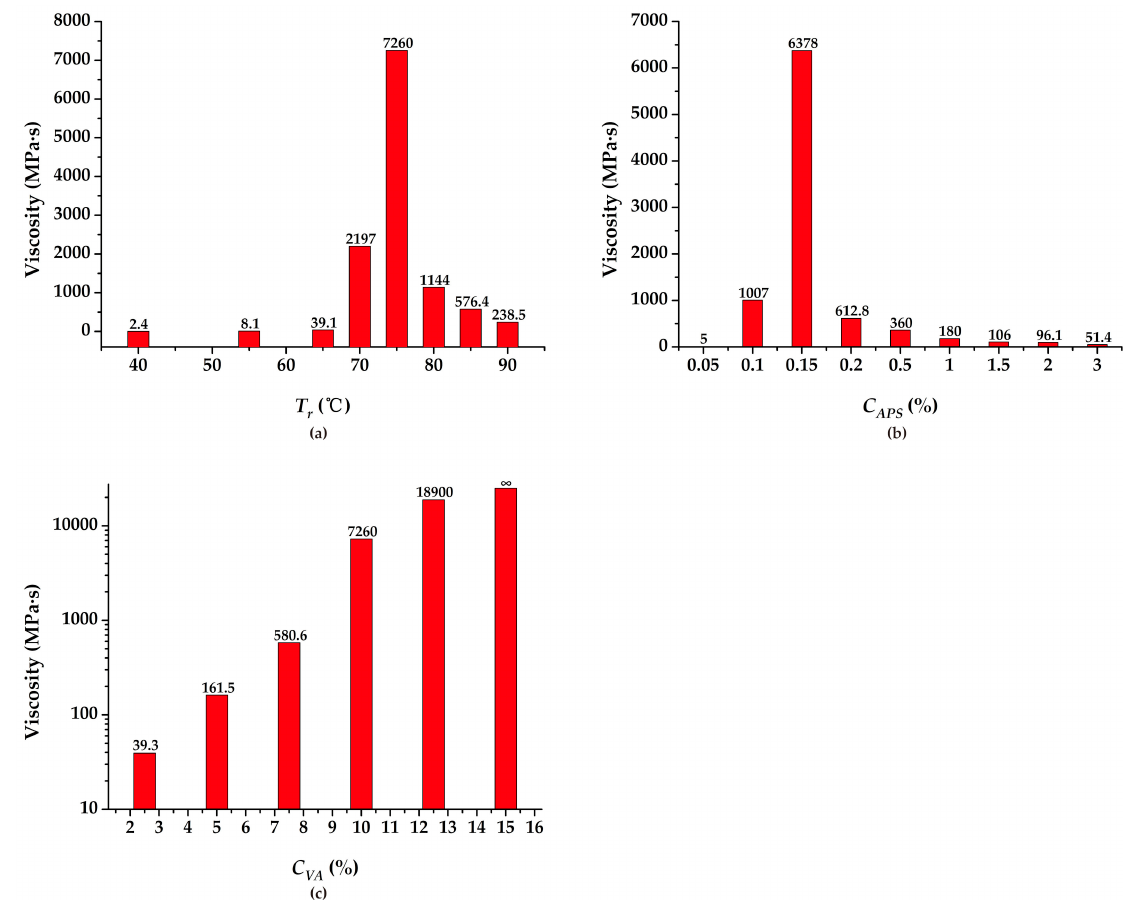
Figure 2. The influence factors of viscosity value: ( a ) reaction temperature ( T r ); ( b ) initiator concentration ( C APS ); ( c ) monomer concentration ( C VA ).